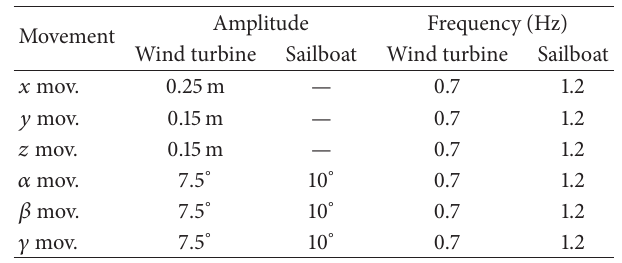
Table 1: Critical points of initial position for each movement. Movement